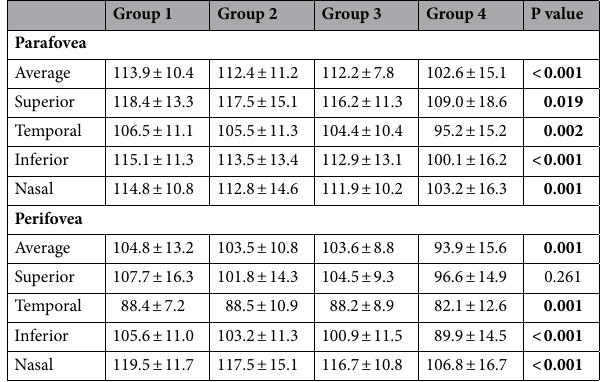
Table 2. Thickness of ganglion cell complex in each group. All values are expressed as the mean ± standard deviation (μm). Values in boldface (P < 0.050) are statistically significant.